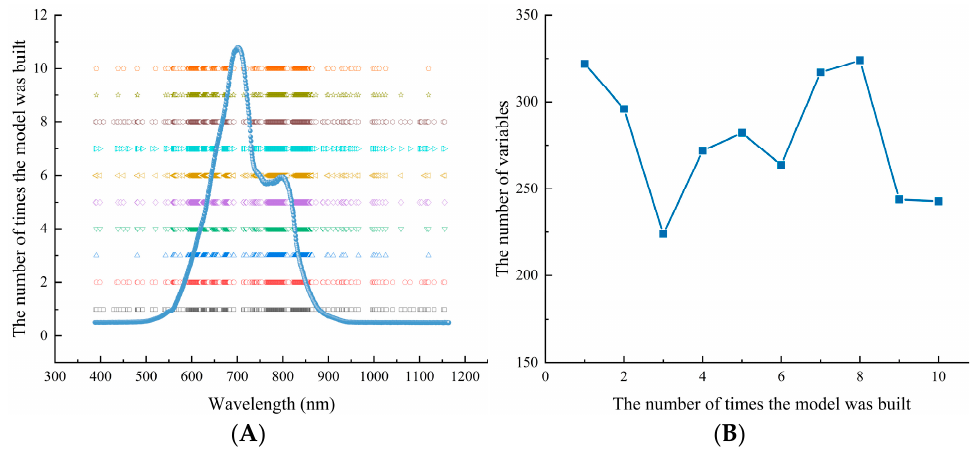
Figure 7. The results of variables selected after 10 runs of MCUVE method: ( A ) variable distribution;